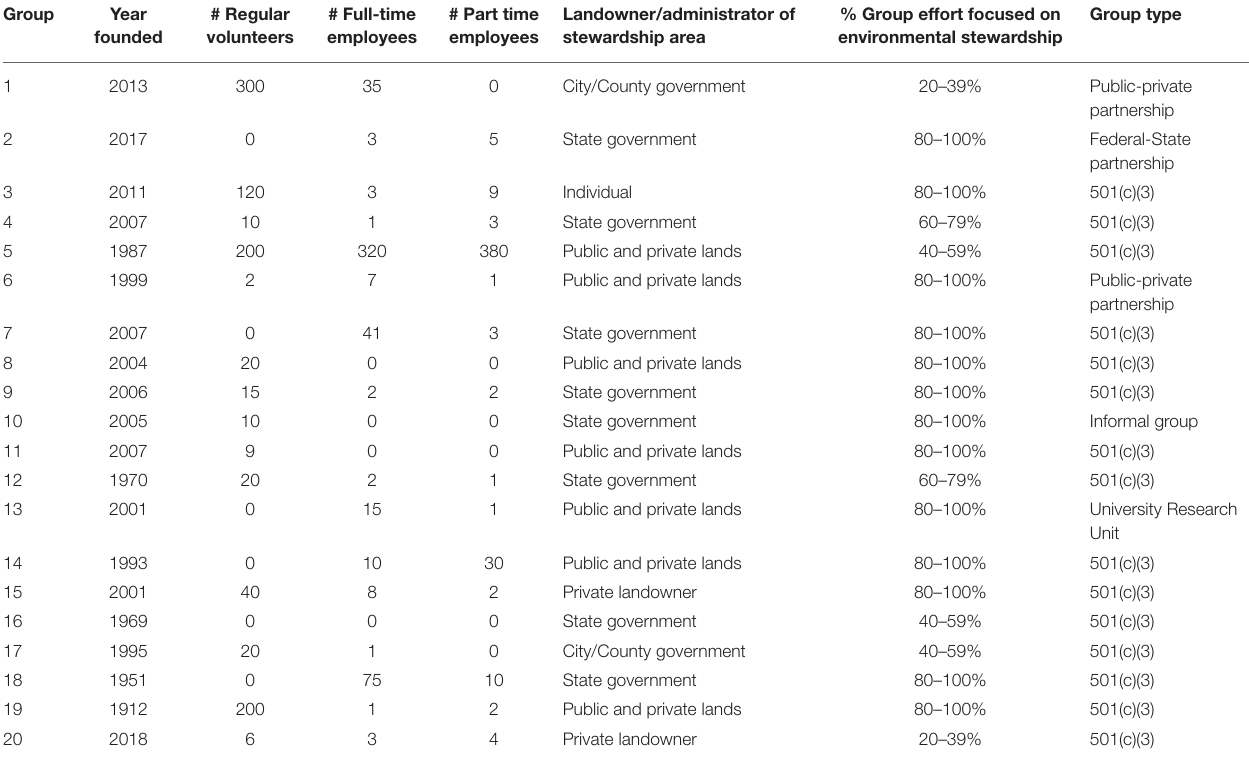
TABLE 1 | Organizational characteristics of the groups that participated in interviews.